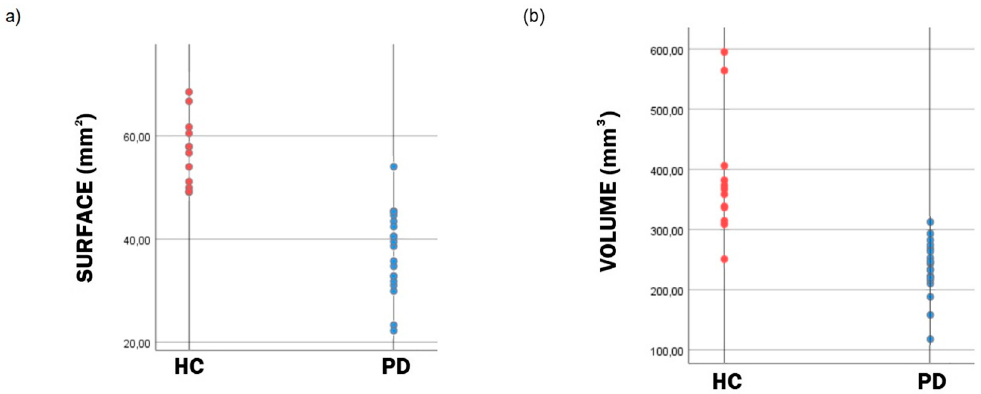
Figure 3. Scatter plots of the surface ( a ) and volume ( b ) of the segmented substantia nigra (SN). Distribution of the substantia nigra (SN) surface ( a ) and volume ( b ) data indicates that both the surface and volume of the SN is lower in patients with Parkinson’s disease (PD) in comparison to healthy controls (HC). Table 2. Surface, volume and signal intensity of the substantia nigra.